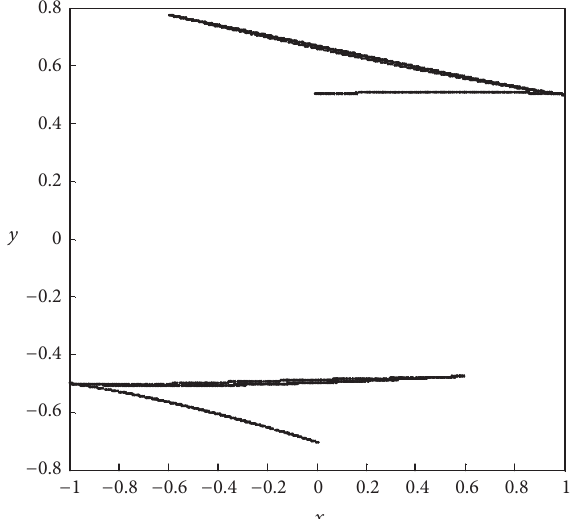
Figure 4: The strange attractor of 𝐹(𝑥,𝑦) (the parameters are the same as Figure